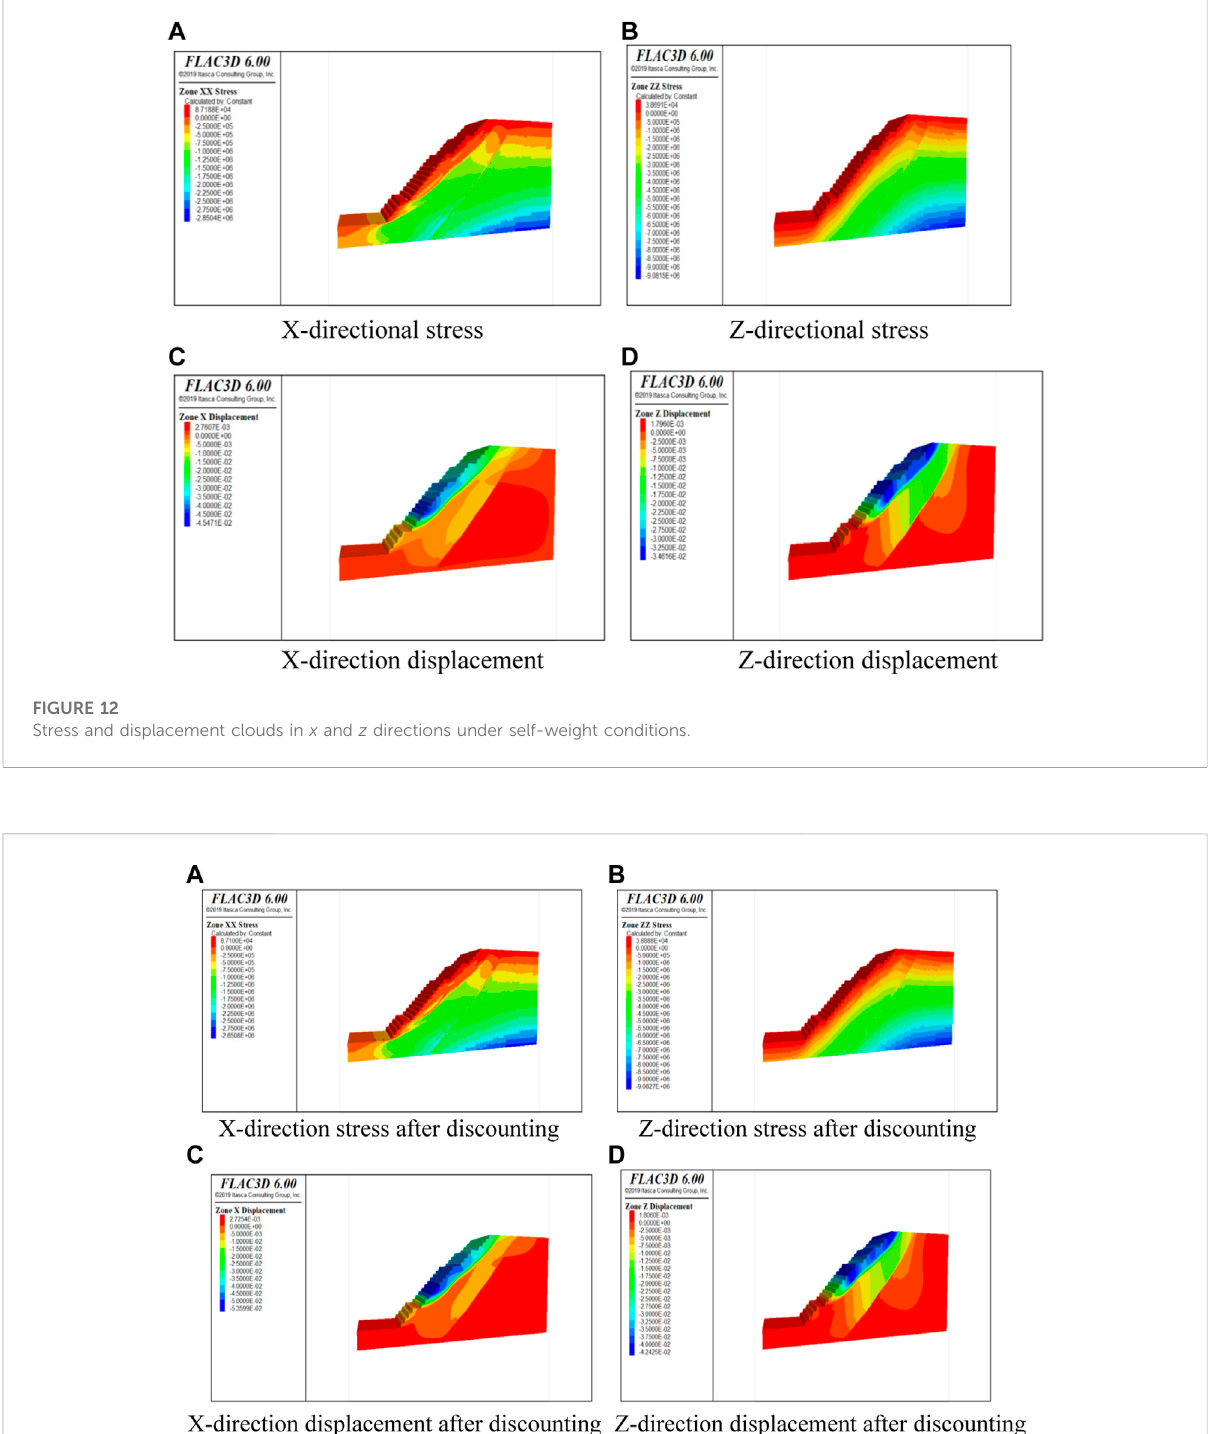
FIGURE 13 Stress and displacement clouds after strength